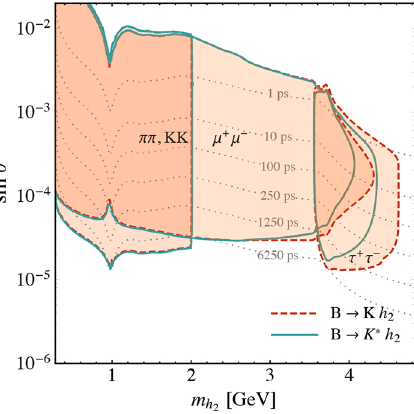
Fig. 3 Parameter regions that correspond to three or more events of B → Kh 2 ( → f ) , f = (ππ + K K ),μ + μ − ,τ + τ − are shaded in red and bounded by the dashed red contours. Analogous regions for B → K ∗ h 2 are presented by the dark green contour. We summed over the number of events in the decays of B + , B − , B 0 , and ¯ B 0 . The dotted lines are contours of constant h 2 proper lifetime